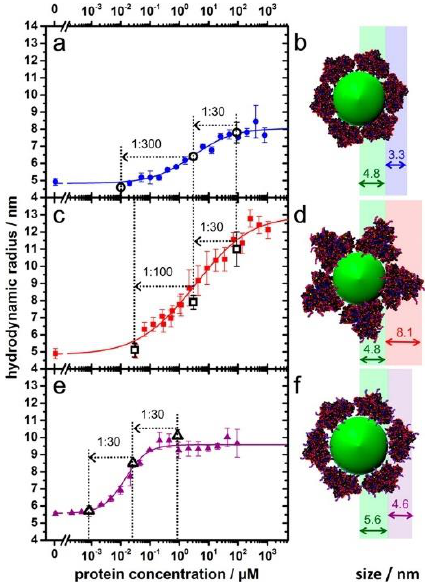
Figure 5. Adsorption of HSA ( a , b ) and succinic anhydride ( c , d ) and ethylenediamine surface ( e , f ) modified HSA onto dihydrolipoic acid-coated quantum dots obtained from fluorescence correlation spectroscopy (FCS). Reprinted with permission from [65]. Copyright (2014) American Chemical Society.